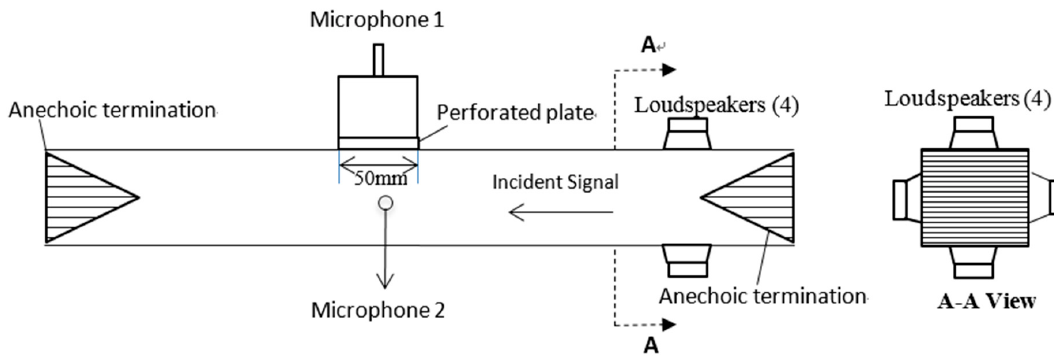
Figure 7. Experimental Test Rig Setup.